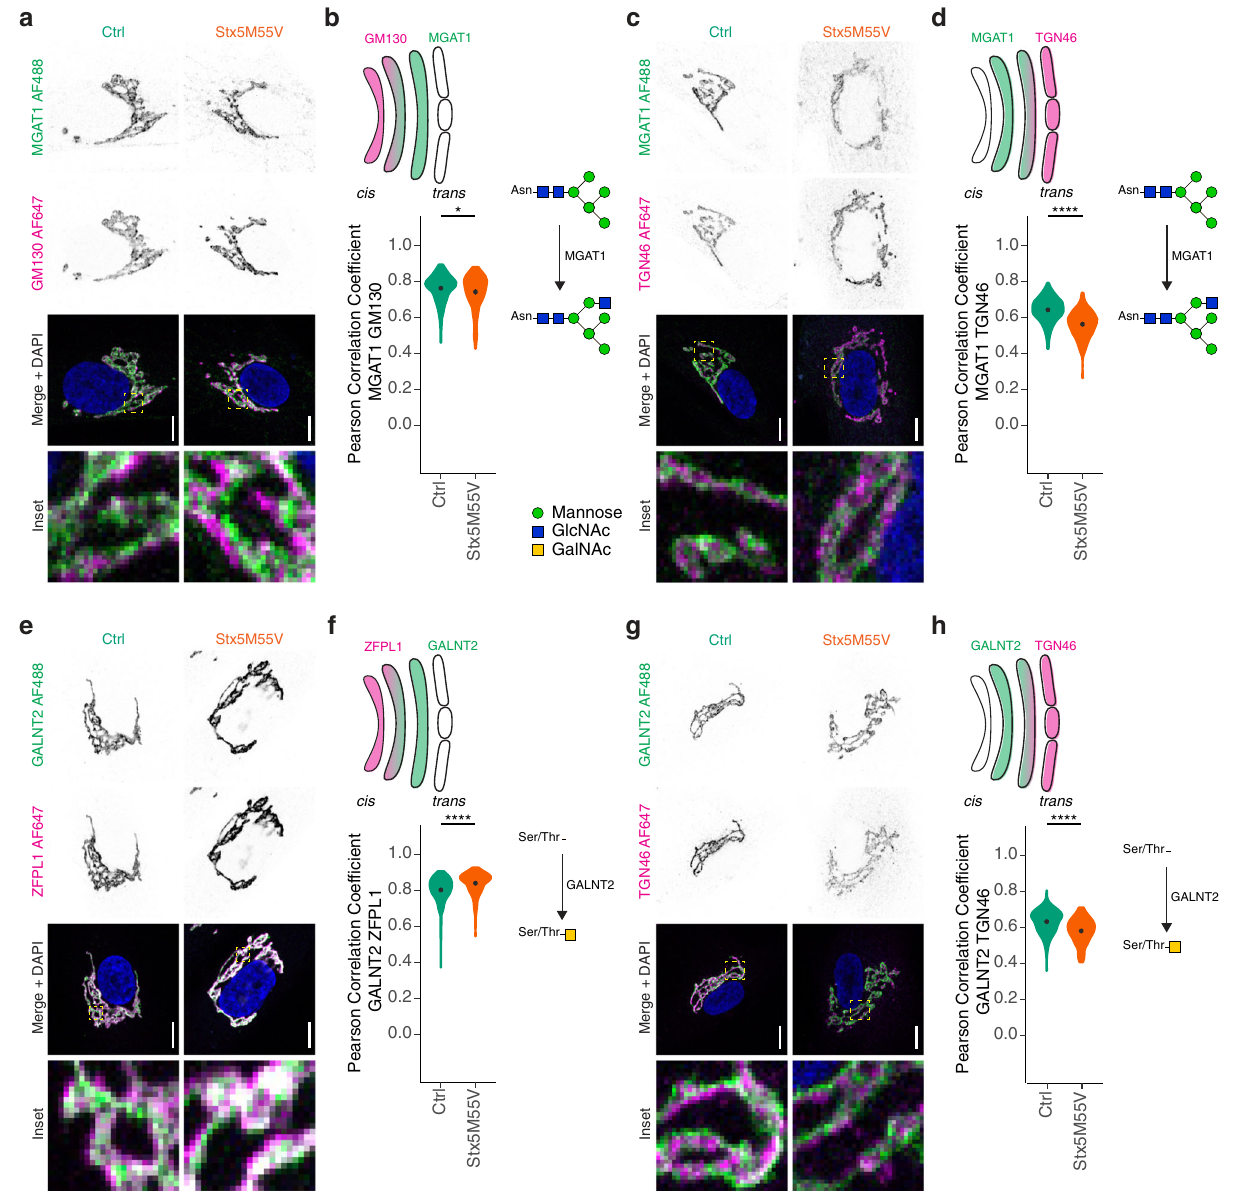
Fig. 3 Glycosylation enzymes mislocalize in Stx5M55V patient fi broblasts. a Immuno fl uorescence microscopy of MGAT1 (green in merge) and GM130 (magenta) in primary dermal fi broblasts of healthy donors (green, Ctrl) or Stx5M55V patients (orange, Stx5M55V). Representative confocal micrographs. Scale bars, 10 µ m. DAPI in blue. N = 157 (Ctrl) and 126 (Stx5M55V) cells from two unique individuals tested twice. b Pearson ’ s correlations coef fi cients between MGAT1 and GM130 of panel ( a ). N = 157 (Ctrl) and 126 (Stx5M55V) from two unique individuals tested twice. Mean ± 95% CI. Unpaired two- sided Student ’ s t -test. * P = 0.047. c , d Same as panels ( a , b ), but now for MGAT1 (green) and TGN46 (magenta). N = 157 (Ctrl) and 162 (Stx5M55V) cells from two unique individuals tested twice. Scale bars, 10 µ m. Mean± 95% CI. Unpaired two-sided Student ’ s t -test. **** P < 2.2 × 10 − 16 . e , f Same as panels ( a , b ), but now for GALNT2 (green) and ZFPL1 (magenta). N = 240 (Ctrl) and 146 (Stx5M55V) cells from two unique individuals tested twice. Scale bars, 10 µ m. Mean± 95% CI. Unpaired two-sided Student ’ s t -test. **** P = 5.9 × 10 − 7 . g , h Same as panels ( a , b ), but now for GALNT2 (green) and TGN46 (magenta). N = 172 (Ctrl) and 152 (Stx5M55V) cells from two unique individuals tested twice. Scale bars, 10 µ m. Mean ± 95% CI. Unpaired two-sided Student ’ s t -test. **** P = 1.7 × 10 − 11